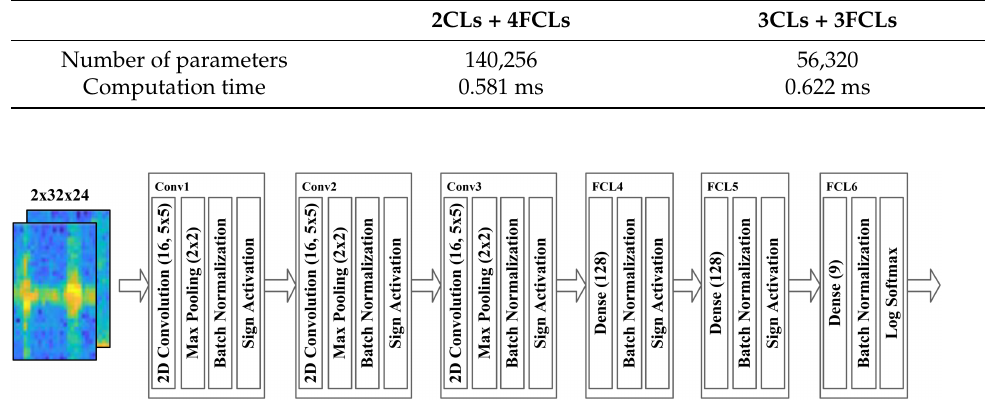
Table 4. Number of parameters and inference computation times.